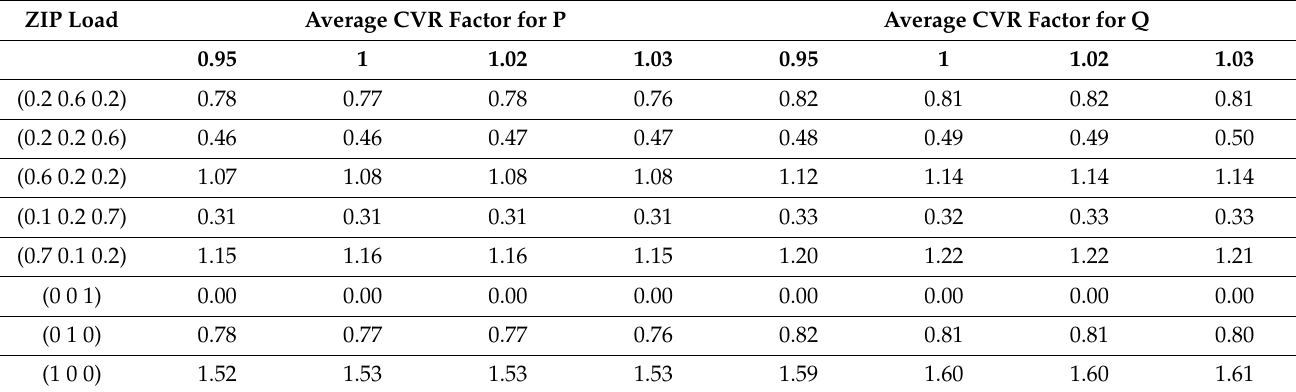
Table 7. Average CVR factor obtained using power captured at load for case 3.